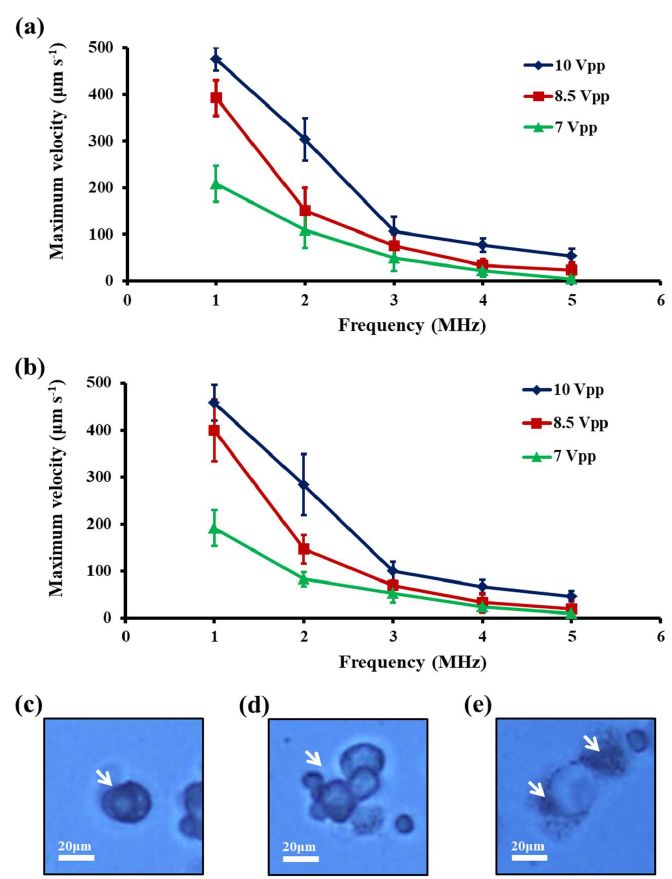
Figure 2. The quantitative relationship between the maximum velocity of a moving light bar that could manipulate the ( a ) PC-3 and ( b ) SK-BR-3 cancer cells tested and the frequency (1, 2, 3, 4, and 5 MHz) of the electric voltage applied under di ff erent voltage magnitudes (7, 8.5, and 10 Vpp) conditions and bright-field microscopic images showing the phenomena of ( c ) cell adhesion (10 Vpp and 500 kHz), ( d ) cell aggregation (10 Vpp and 750 kHz), and ( e ) cell lysis (10 Vpp and 100 kHz), during the exposure of cancer cells to the ODEP field with a voltage magnitude and frequency, as